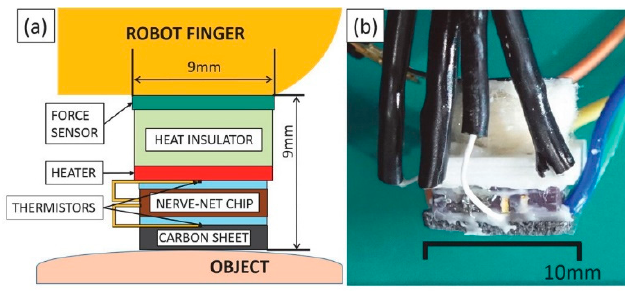
Figure 3. ( a ) Structure model of sensor head; ( b ) Photograph of sensor head.